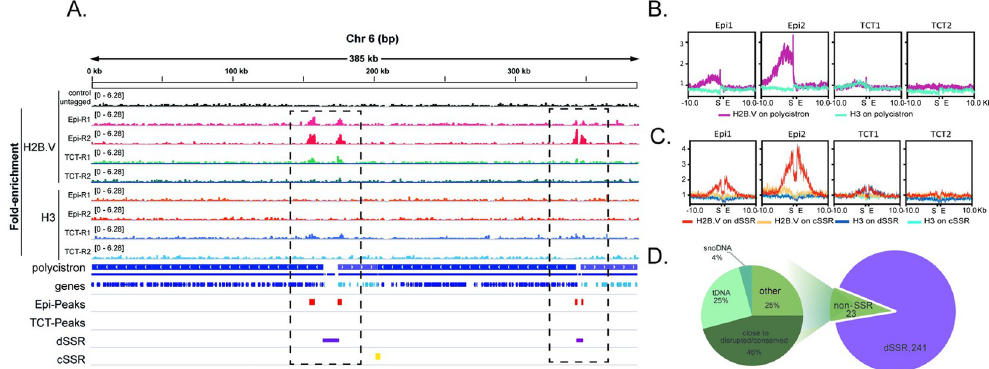
Fig 1. H2B.V is enriched at dSSRs of epimastigote forms. A. IGV snapshot of whole chr 6S of the CL Brener Esmeraldo- like haplotype using the wig files from the ChIP H2B.V/input and ChIP H3/input ratios obtained by COVERnant v.0.3.2. Note that H2B.V, but not H3, is enriched at dSSRs. Blue bar arrows indicate the transcription direction in each polycistron. Genes in the same polycistron are stained with the same color. dSSRs, purple bars; cSSRs, yellow bars. Red bars represent H2B.V peaks (fold equal to 4 over the input, Poisson p-value over input required = 1.00e-04) obtained by HOMER in the epimastigote form. Rectangles with interrupted lines highlight dSSRs. Summary plot obtained by deepTools for H2B.V and